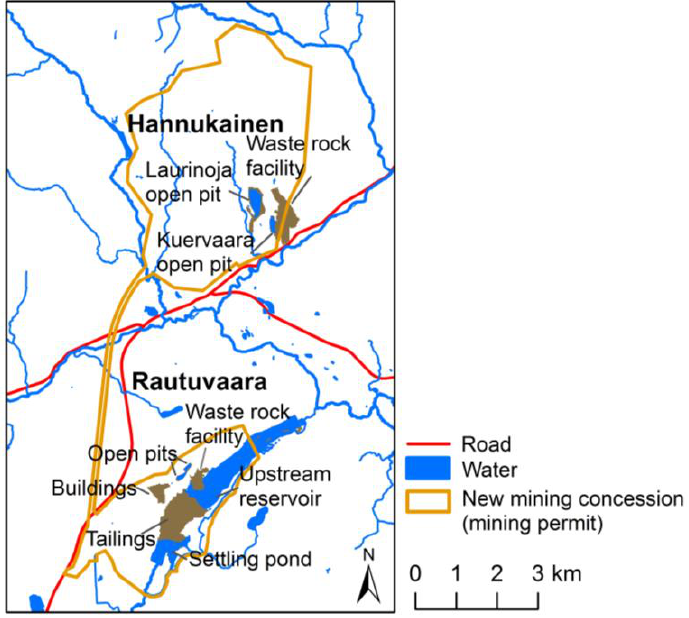
Figure 2. Specific mining elements remaining at the closed Hannukainen and Rautuvaara sites and the area covered by a new mining concession (mining permit) (see [65 – 71] for more